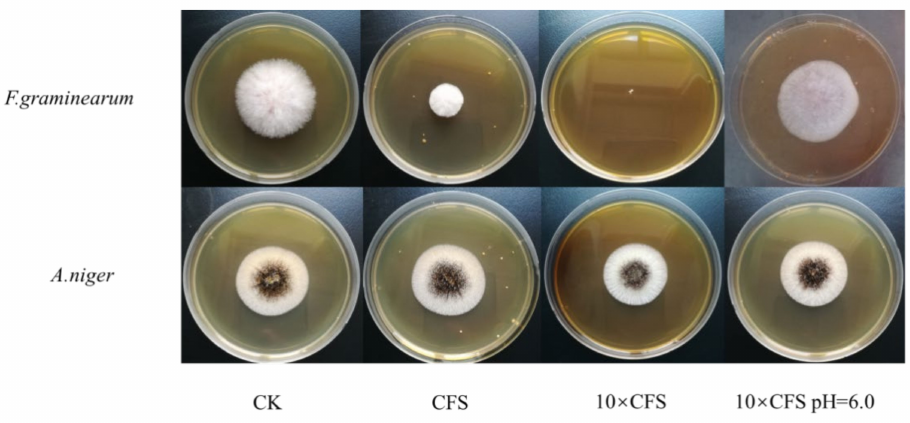
Figure 4. Antifungal effects of the concentrated culture filtrate of ZZUA493 against F.graminearum and A. niger . F. graminearum, Fusarium graminearum; A. niger, Aspergillus niger; CK, no LAB CFS control; CFS, cell-free supernatant; 10 × CFS, 10-fold-concentrated cell-free supernatant; 10 × CFS pH = 6.0, the pH of 10 × CFS was adjusted to